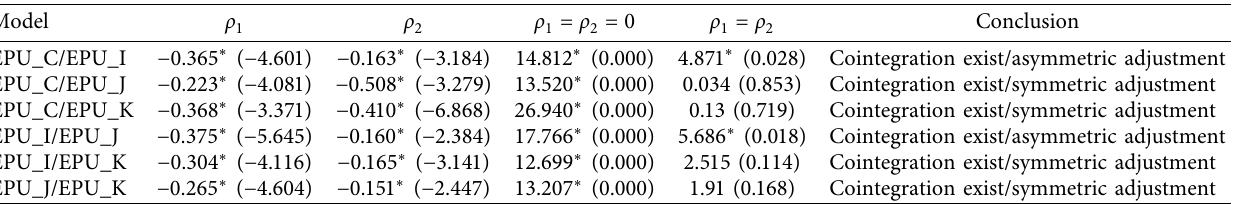
Table 7: Enders-Siklos cointegration test results according to the M-TAR